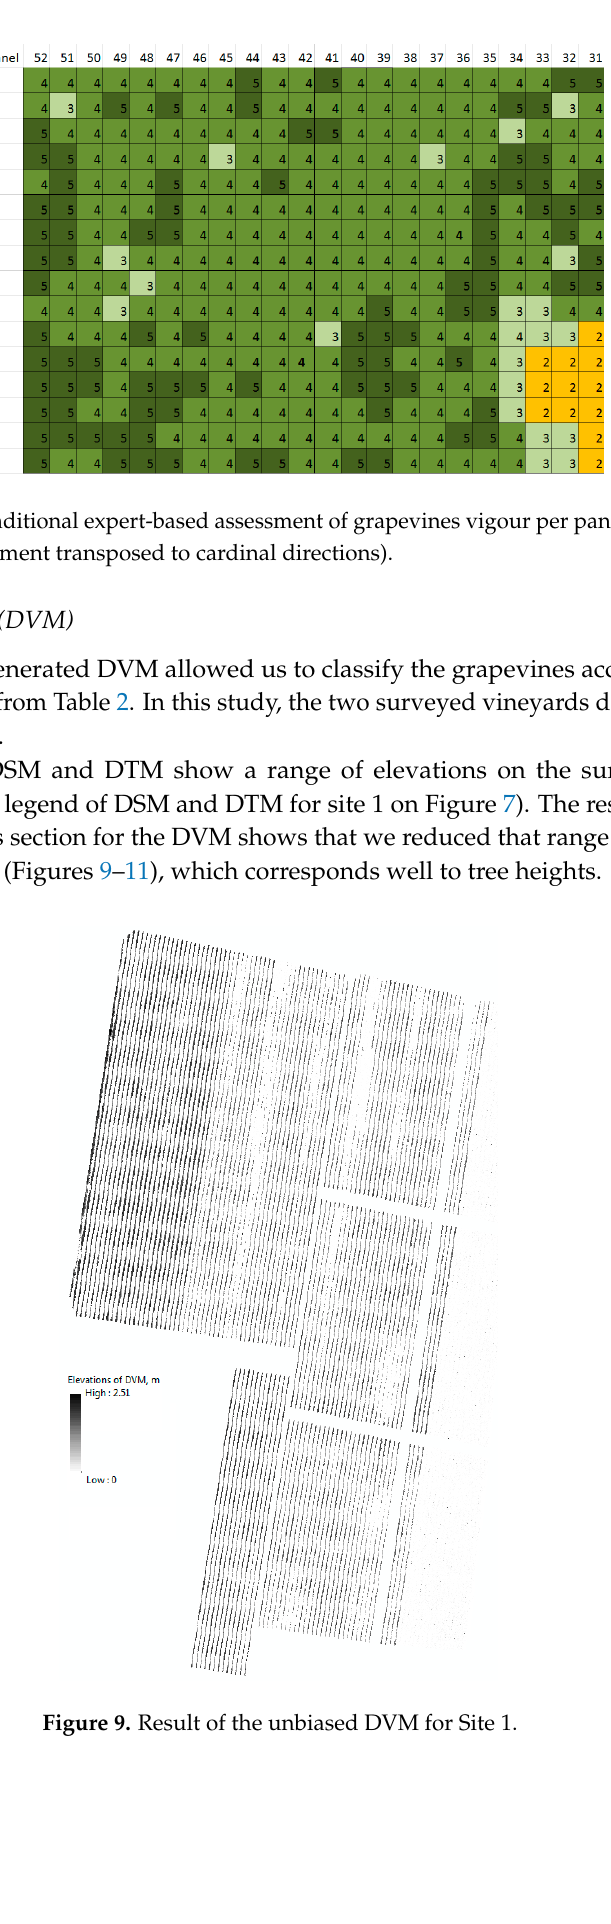
11 of 21 Figure 7. Result of the digital surface model (DSM) and digital terrain model (DTM) of Site 1. Markers are the ground control points (GCP). 5. Results and Discussion 5.1. Visual Vigour Assessment Results